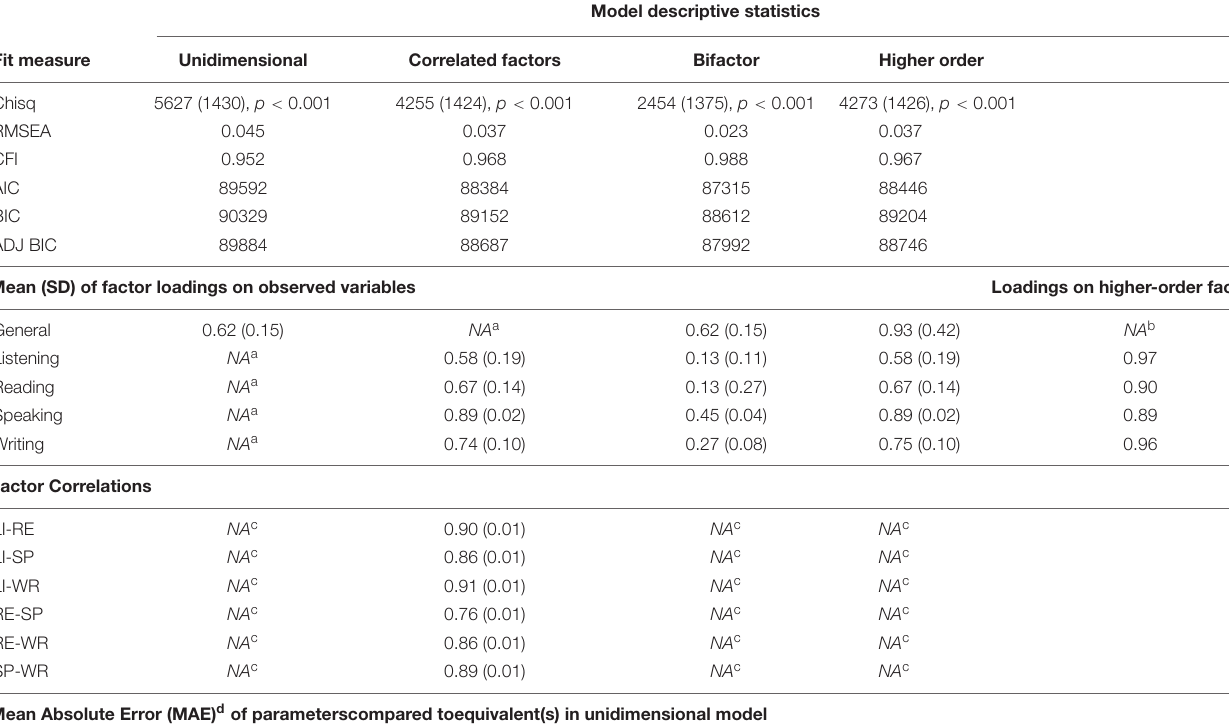
TABLE 2 | Four-skills model fit and parameter